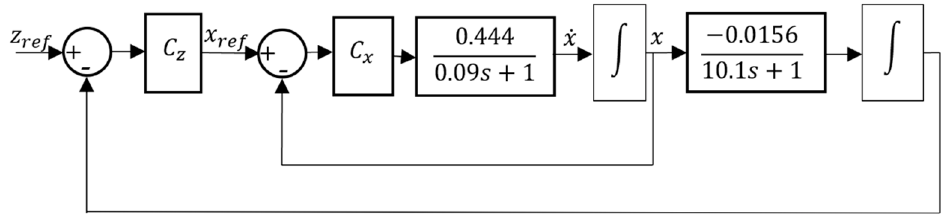
Figure 9. Controller structure used in this work.